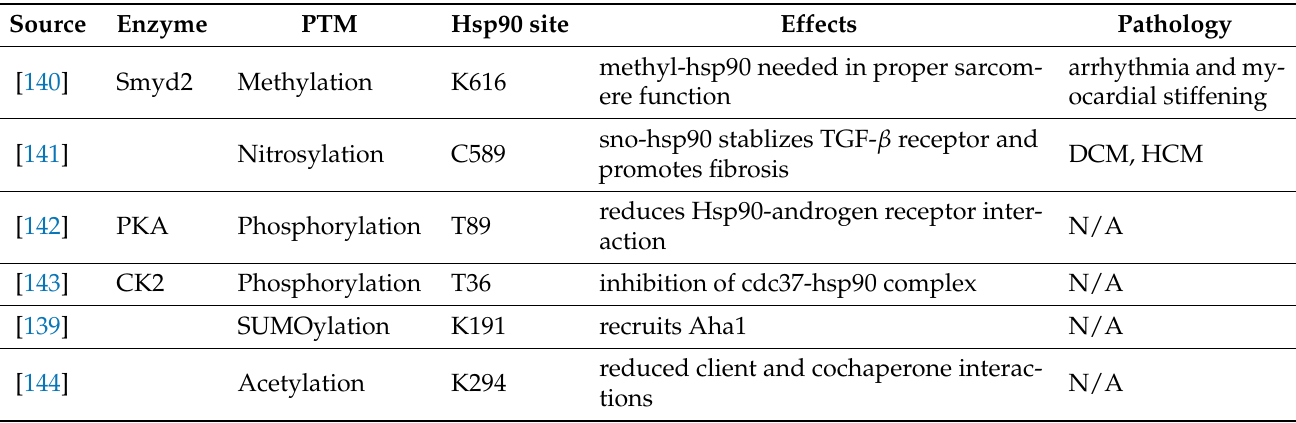
Table 2. This table summarizes Hsp90 PTMs. The headers of the table are as follows: “Enzyme” is the enzyme that does the PTM. “PTM” is the type of modification. “Hsp90 Site” is this amino acid location of the modification. “Effect” describes experimental findings of the